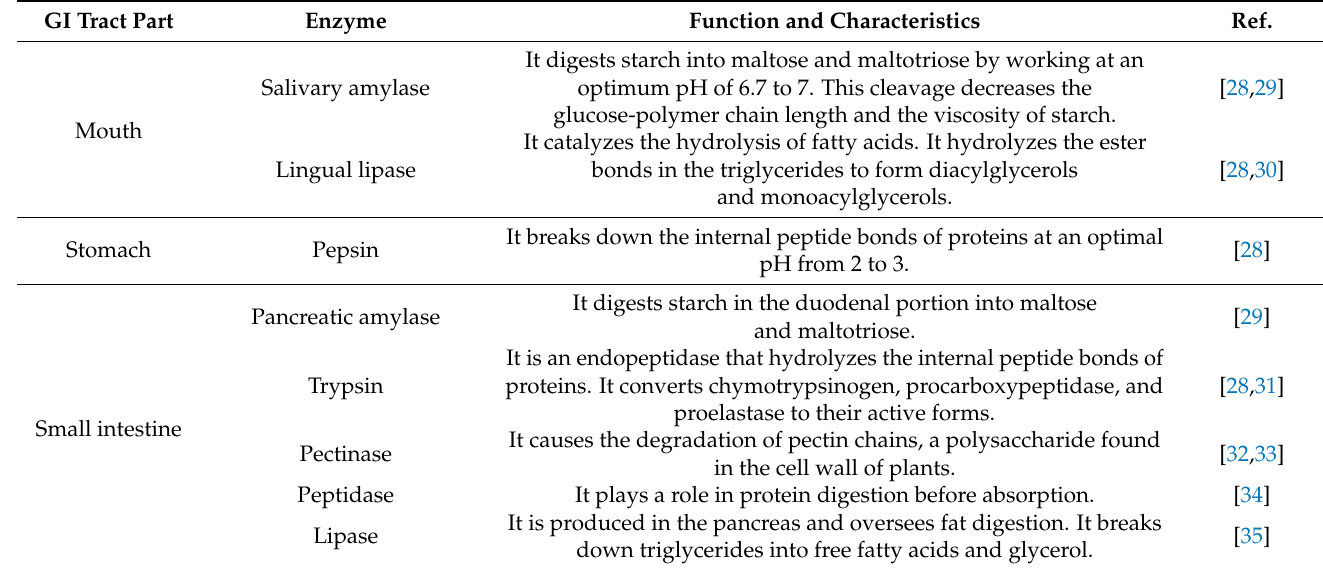
Table 1. Function and characteristics of the enzymes present in different components of the